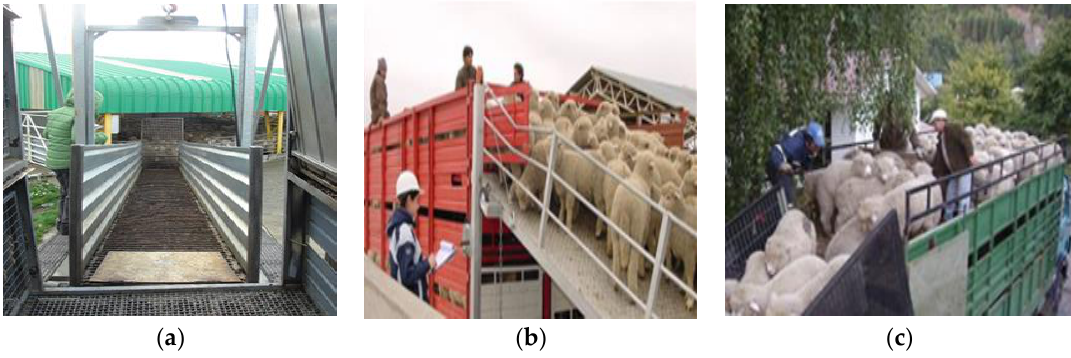
Figure 5. ( a – c ) Unloading lambs at the slaughterhouse using mobile metallic ramps.